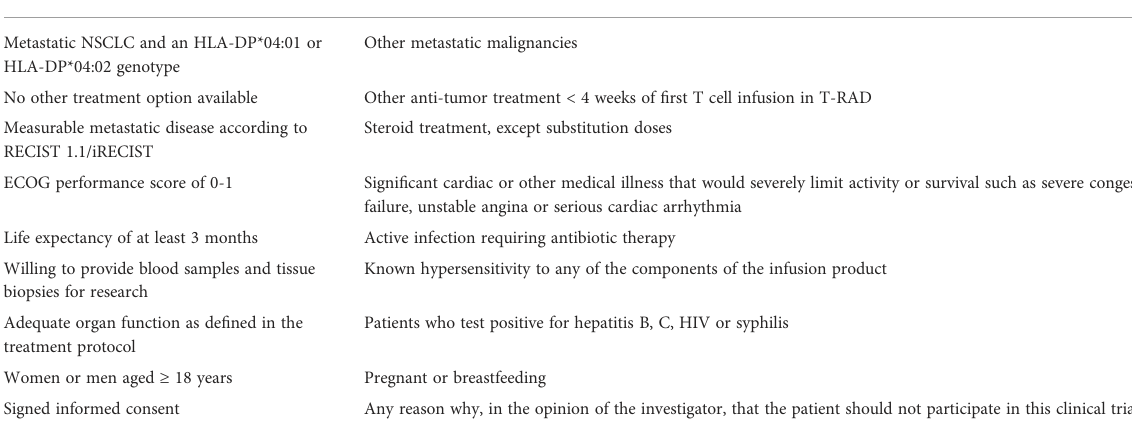
TABLE 3 List of selected inclusion and exclusion criteria to be used in the T-RAD clinical study. Inclusion